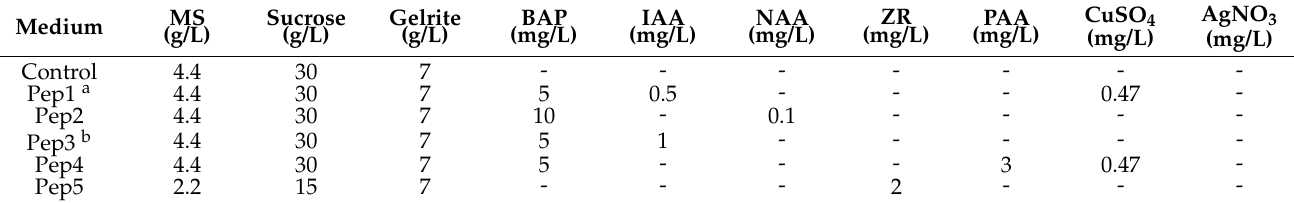
Table 1. Composition of media used to induce direct organogenesis in Capsicum